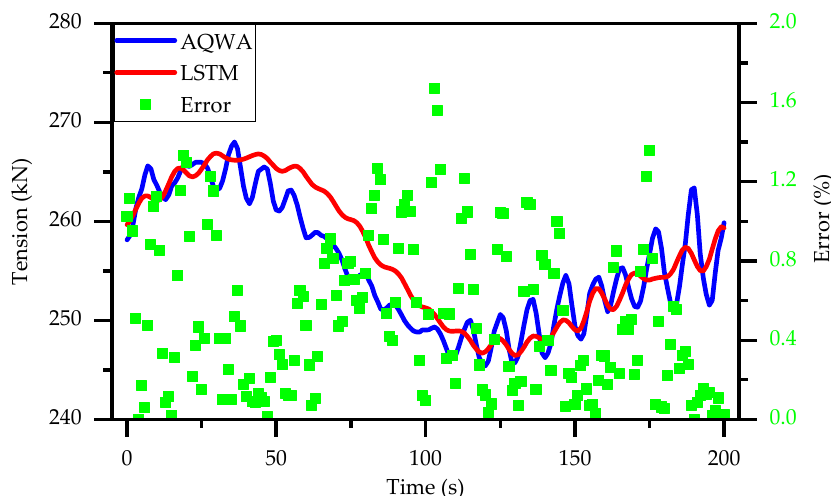
Figure 13. Error analysis of AD32 Mooring Line 3.